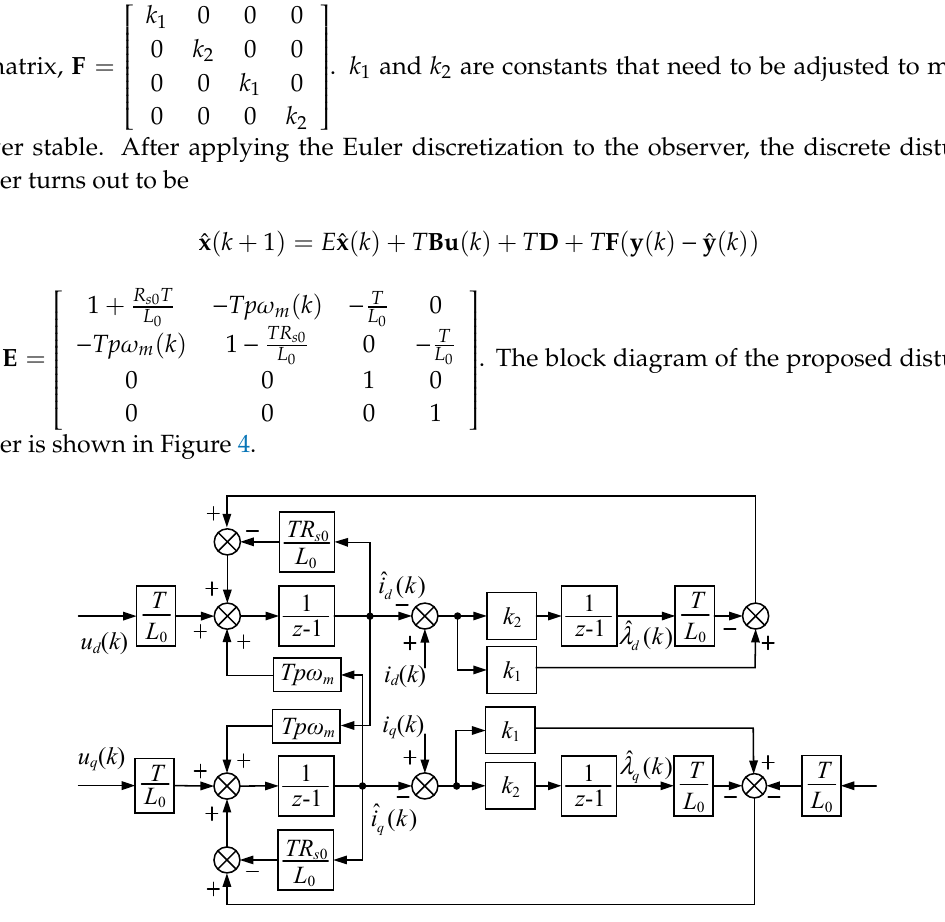
Figure 4. Block diagram of the proposed disturbance observer.